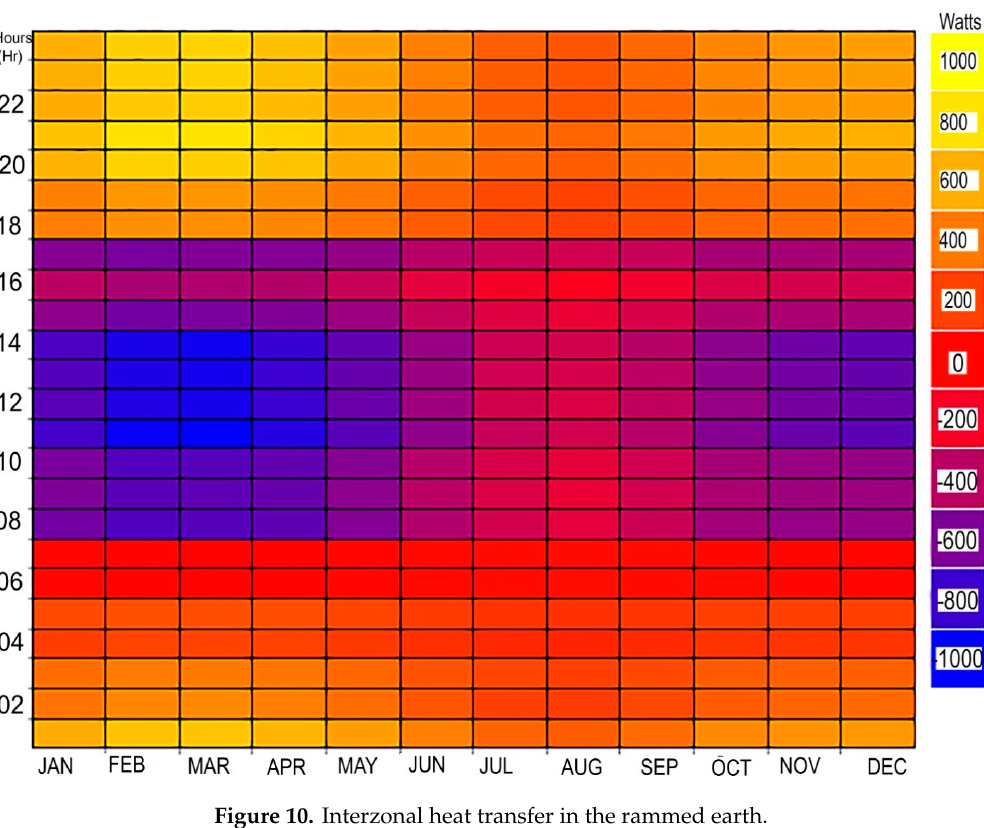
Figure 10. Interzonal heat transfer in the rammed earth.